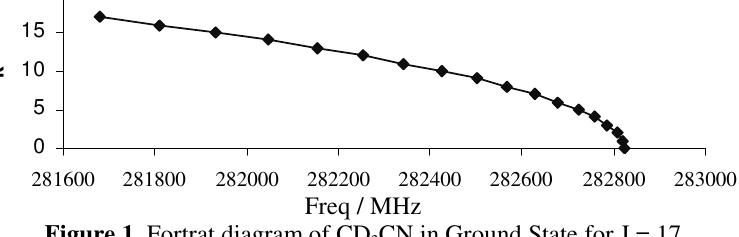
Figure 1 . Fortrat diagram of CD Table 1 . The Results of Refinement of Observed Frequencies for CD